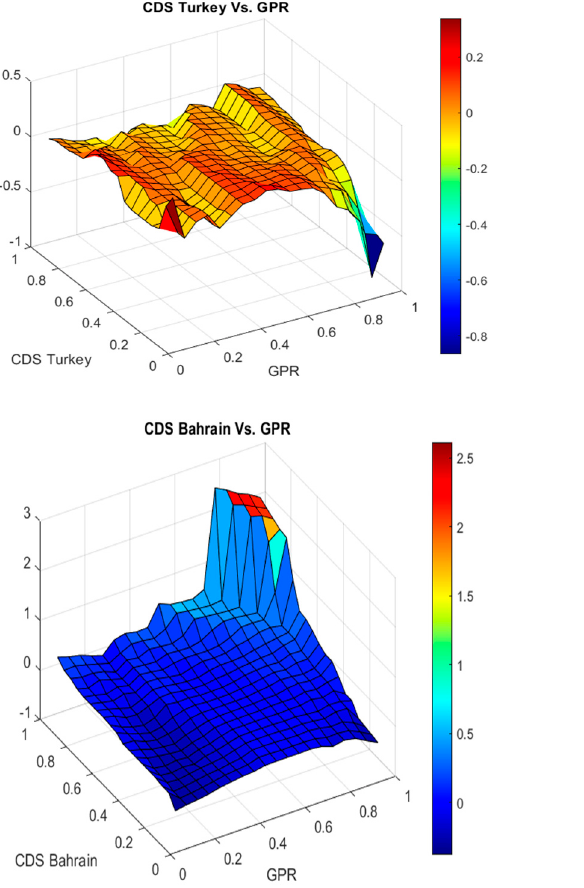
Figure 3. The quantile-on-quantile estimates of the impact of the GPR on nineteen SCDSs. ( a ): The quantile-on-quantile estimates of the impact of the GPR on SCDSs in Europe countries. ( b ): The quantile-on-quantile estimates of the impact of the GPR on SCDSs in American countries. ( c ): The quantile-on-quantile estimates of the impact of the GPR on SCDSs in Asia and African countries.